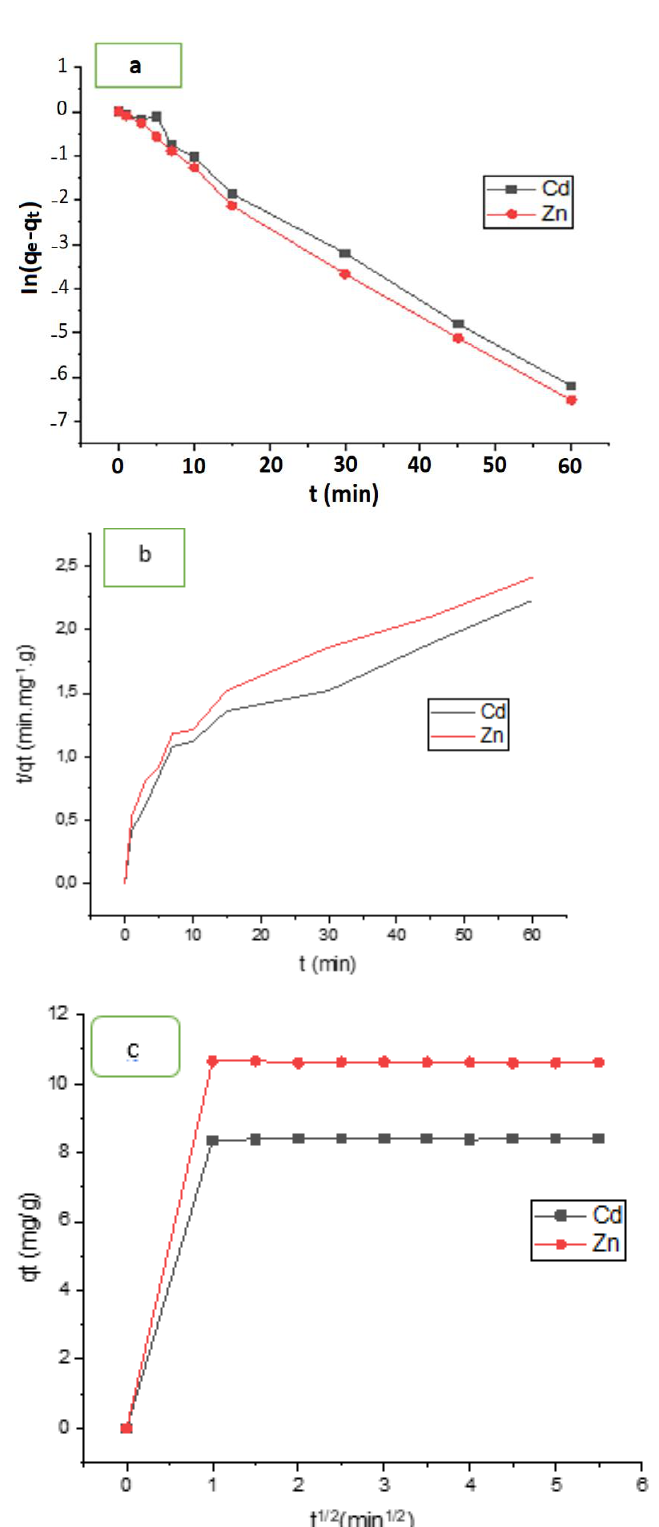
Figure 11. ( a ) Pseudo-first-order; ( b ) Pseudo-second-order; and ( c ) intra-particle diffusion models for Cd 2+ and Zn 2+ .